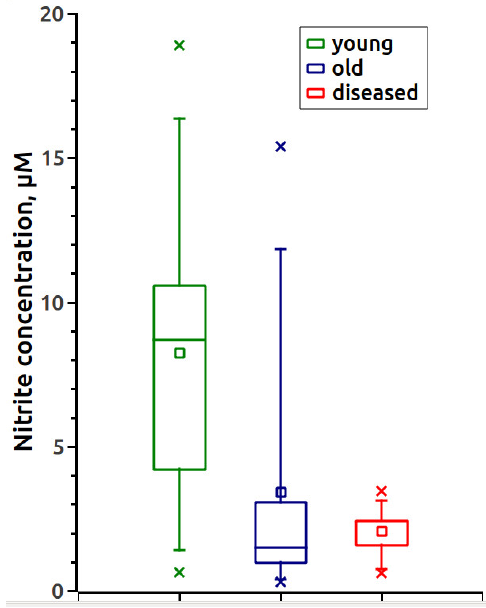
Figure 2. Concentration of serum nitrite in different groups of horses.